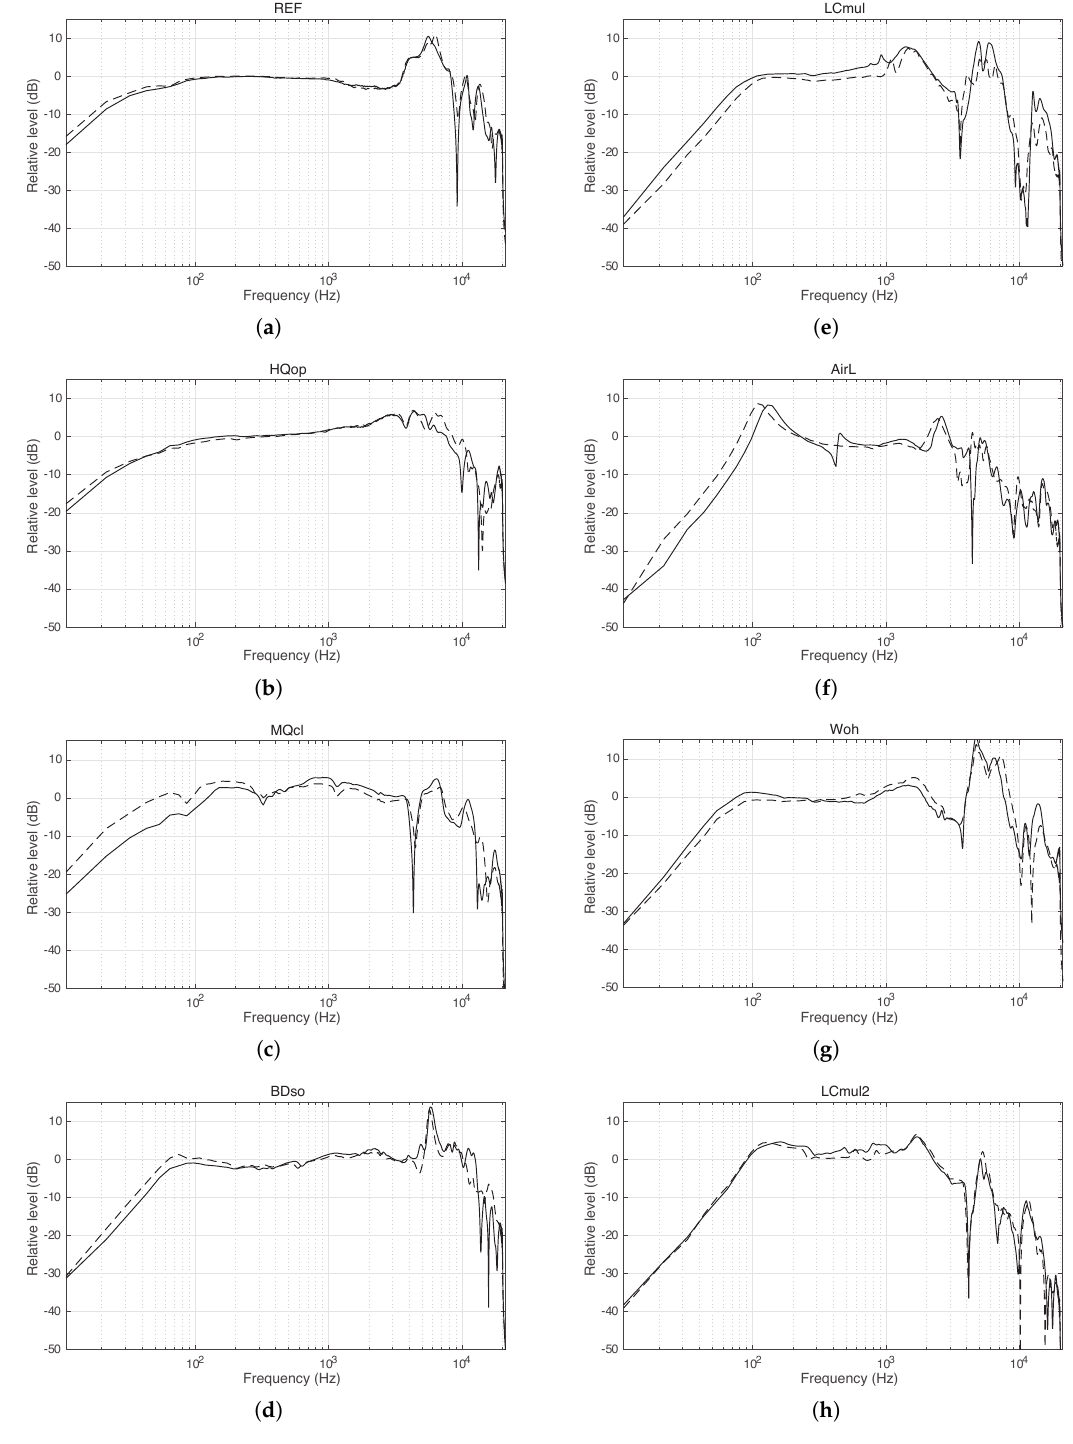
Figure 2. Frequency response of the headphones used in the study. Solid curve, left channel; dashed curve, right channel. ( a ) REF, Reference headphone; ( b – h ) headphones under study. ( b ) HQop, High Quality open headphone; ( c ) MQcl, Medium Quality closed headphone; ( d ) BDso, Big Diaphragm semi-open headphone; ( e ) LCmul, Low Cost multimedia headphone; ( f ) AirL, Airline headphone; ( g ) Woh, Wireless open headphone; ( h ) LCmul2, Low Cost multimedia headphone